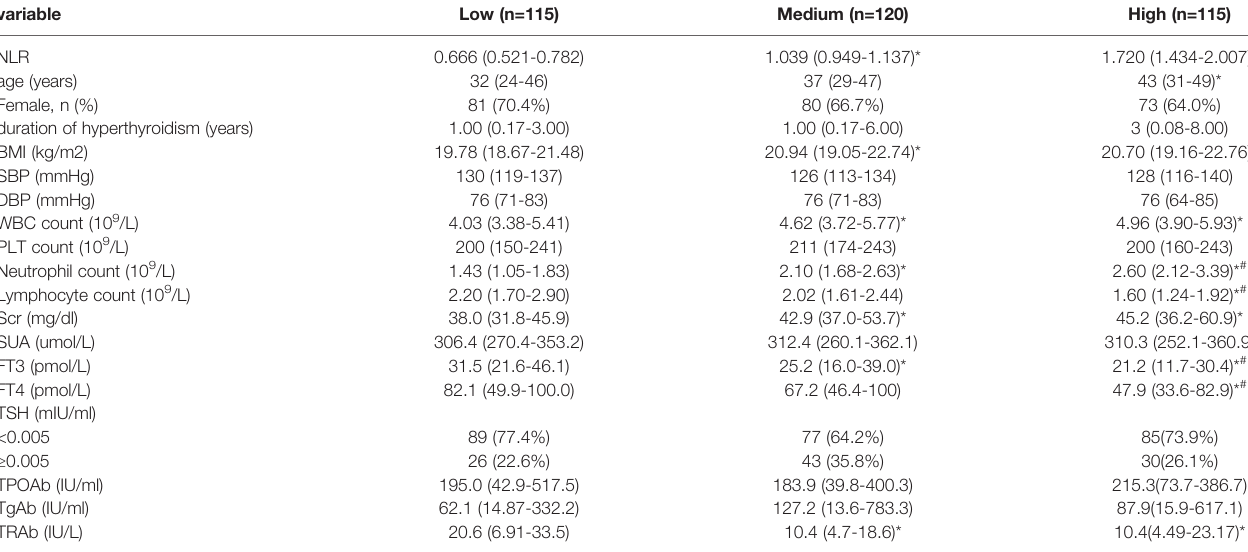
*represents P < 0.05 (medium and/or high group compared with low group respectively). #represents P < 0.05 (comparison between high and medium